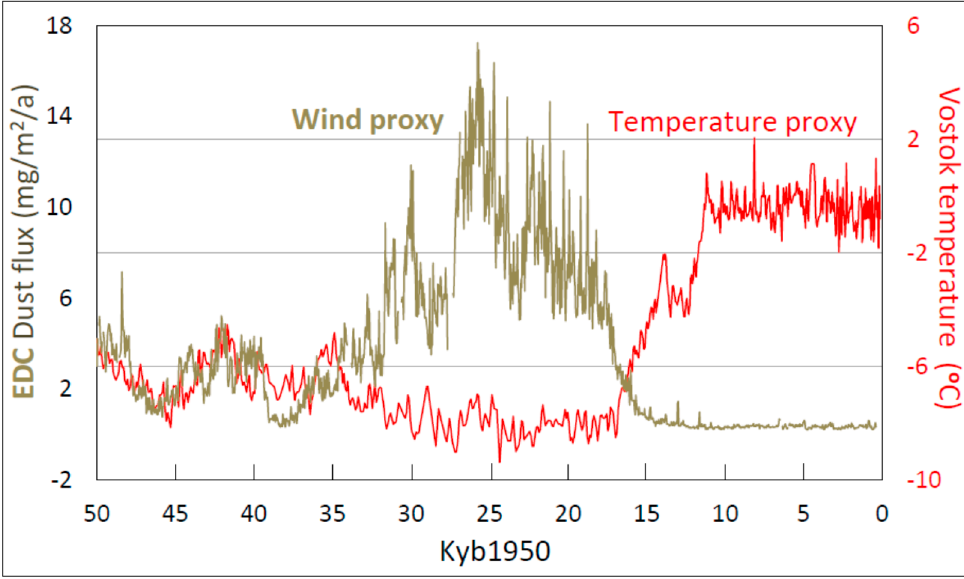
Figure 11. The relationship between wind- and temperature-proxies over the last 50 millennia showing positive correlation at low wind velocity and negative correlation at high wind velocity and during the exceptional calm during the Holocene.